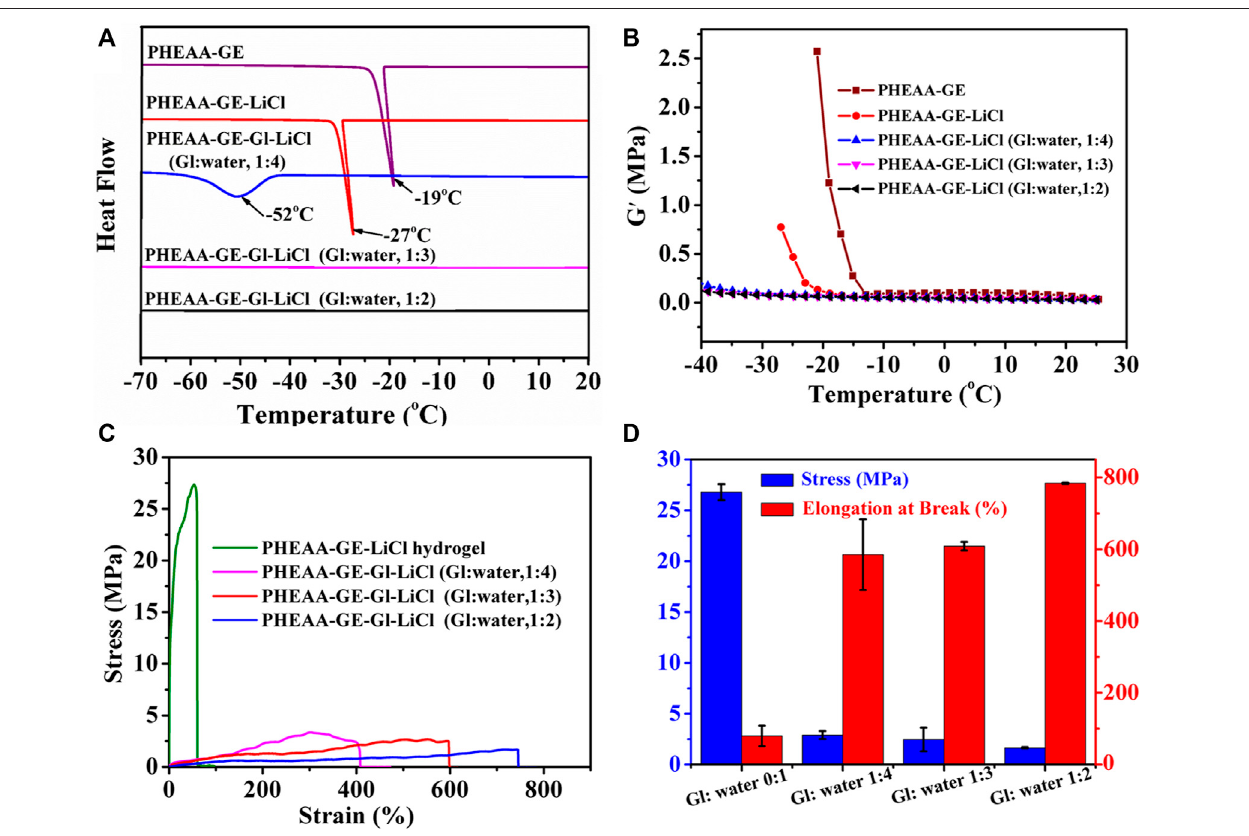
FIGURE 4 | Anti-freezing properties of PHEAA-GE-Gl-LiCl organohydrogels. (A) DSC curves of hydrogel and organohydrogel with different Gl/water ratios (0:1, 1: 4,1:3,and1:2). (B) Storagemodulus(G ′ )ofhydrogelandorganohydrogelwithdifferentGl/waterratios(0:1,1:4,1:3,and1:2)atthetemperaturerangeof25 ° Cto − 40 ° C. The (C) stress-strain curves, (D) stress and elongation at break of PHEAA-GE-LiCl hydrogel and PHEAA-GE-Gl-LiCl organohydrogel with different weight ratios of Gl/ water at − 40 ° C.